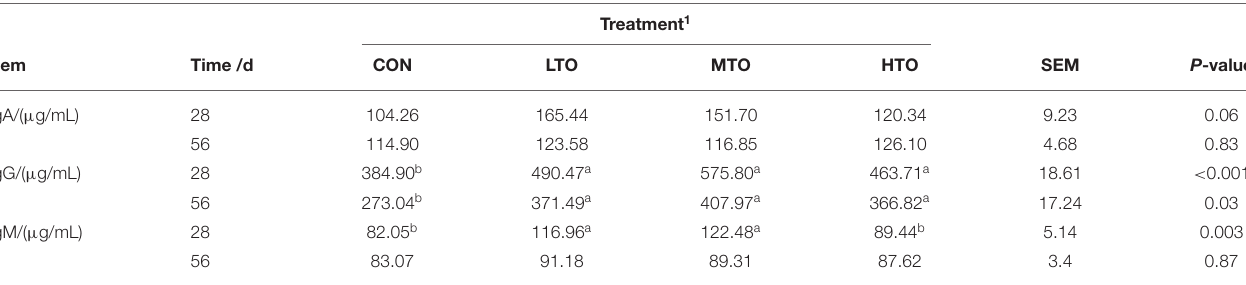
TABLE 4 | Effects of tea tree oil on the serum immunity of finishing pigs ( n =